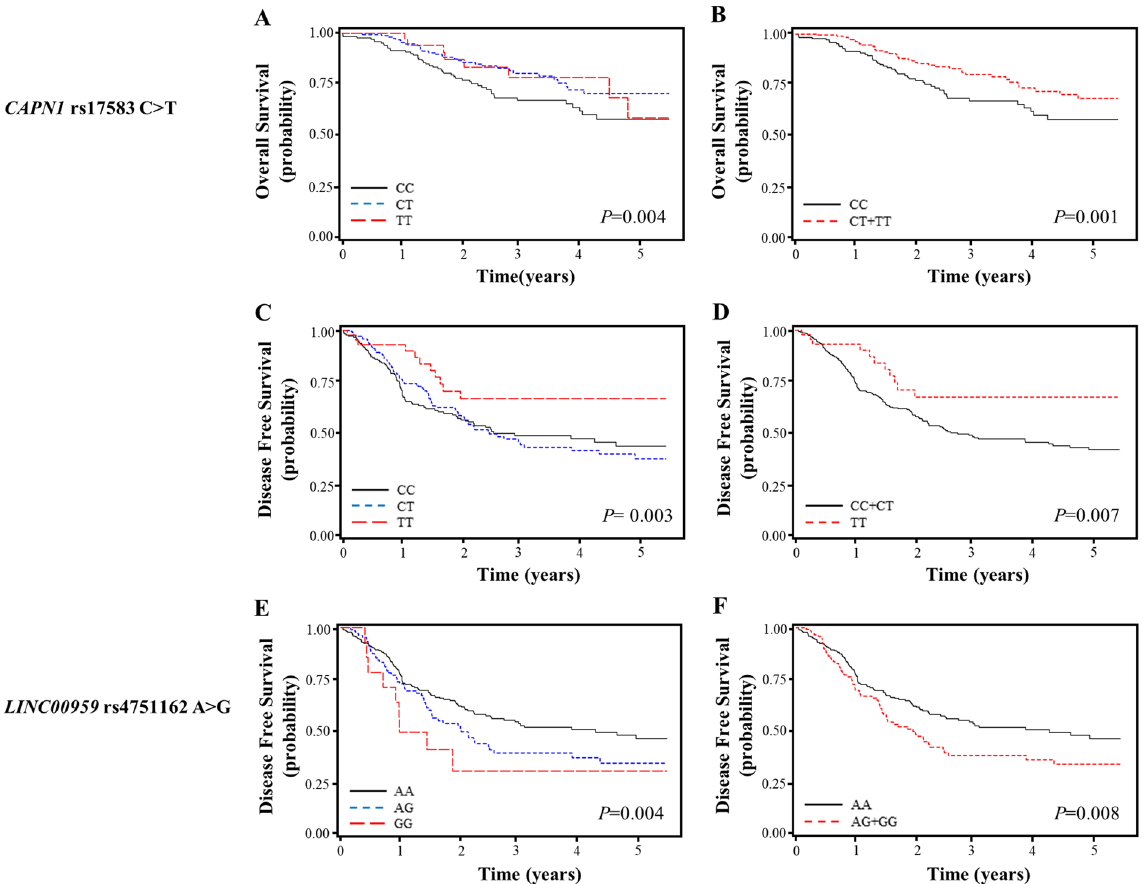
Figure 1. Overall survival ( A , B ) and disease-free survival ( C , D ) according to CAPN1 rs17583C>T genotypes, and disease-free survival ( E , F ) according to LINC00959 rs4751162A>G genotypes. The data were analyzed using SAS. P values in the multivariate Cox proportional hazard